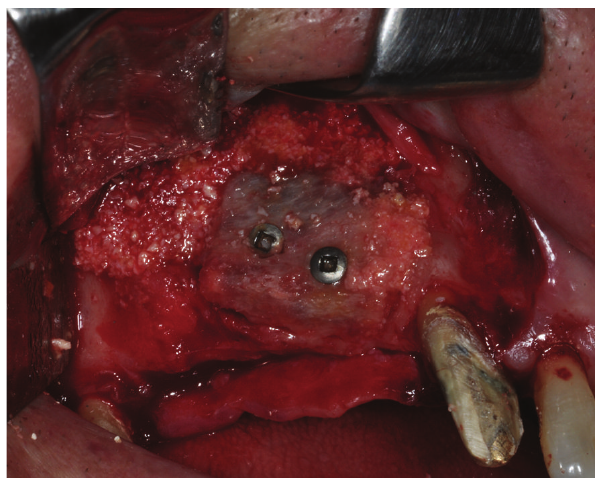
Figure 2: The atrophic upper jaw is treated with a combined sinus lift procedure and local ridge augmentation using fresh frozen homologous grafts.